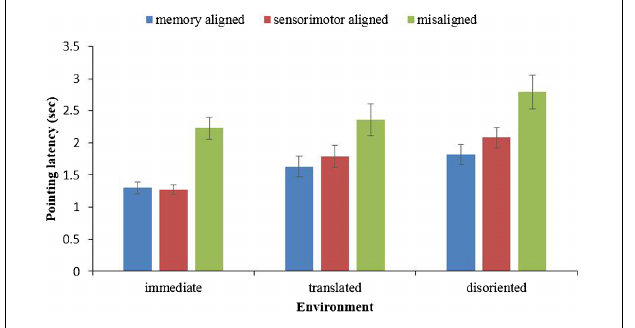
FIGURE 3 | Absolute pointing error in immediate, translated, and disoriented environments, as a function of imagined perspective. Error bars are confidence intervals corresponding to ± 1